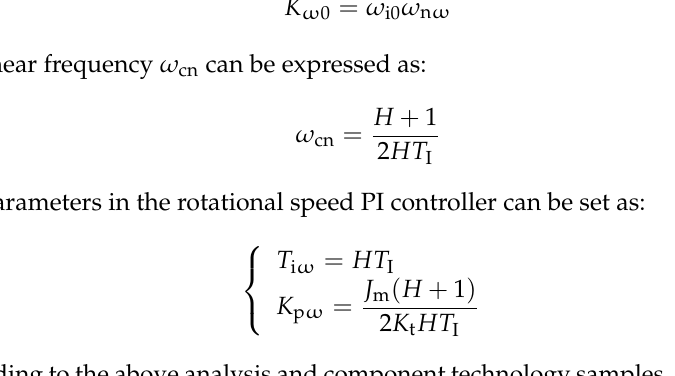
Table 2. Speed loop simulation model parameters. Parameter